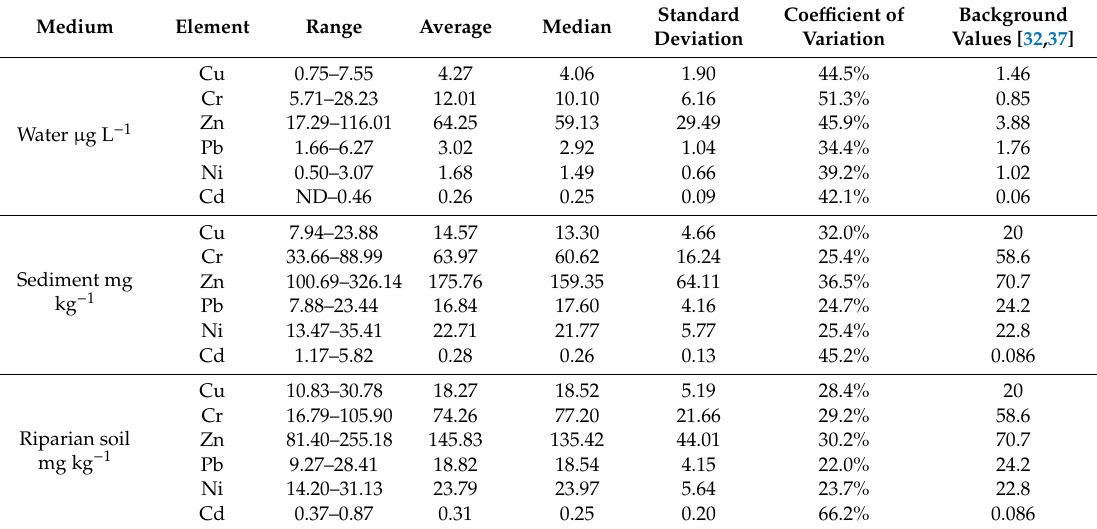
Table 2. Statistical characteristics of heavy metal content in Songhua